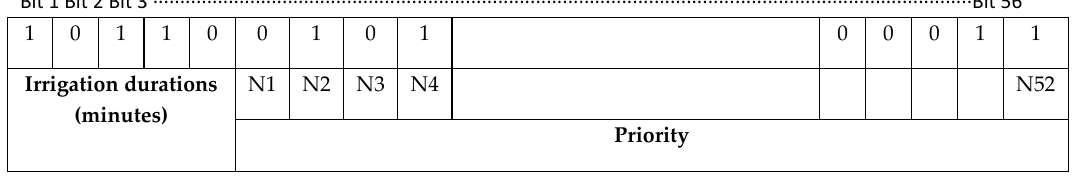
Figure 14. Download message structure in SIGFOX.